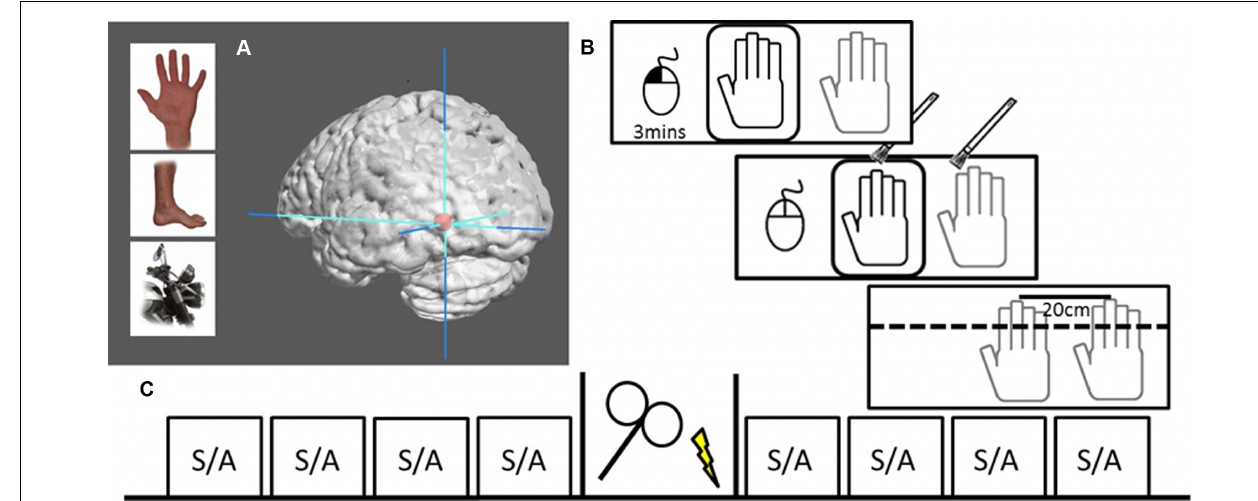
computer mouse, beginning the 3 min session with a left button press. Hand stroking is applied for 3 min, during which participants voluntarily make a left mouse button press to signal that they experience the illusion. At the end of stimulation the viewing window is covered and participants make three perceptual judgments followed by a subjective experience rating. (C) The design of one session, including four pre-TMS blocks of either (S)ynchronous or (A)synchronous stoking, 20 min of either rTMS or sham stimulation, and four post-TMS stroking